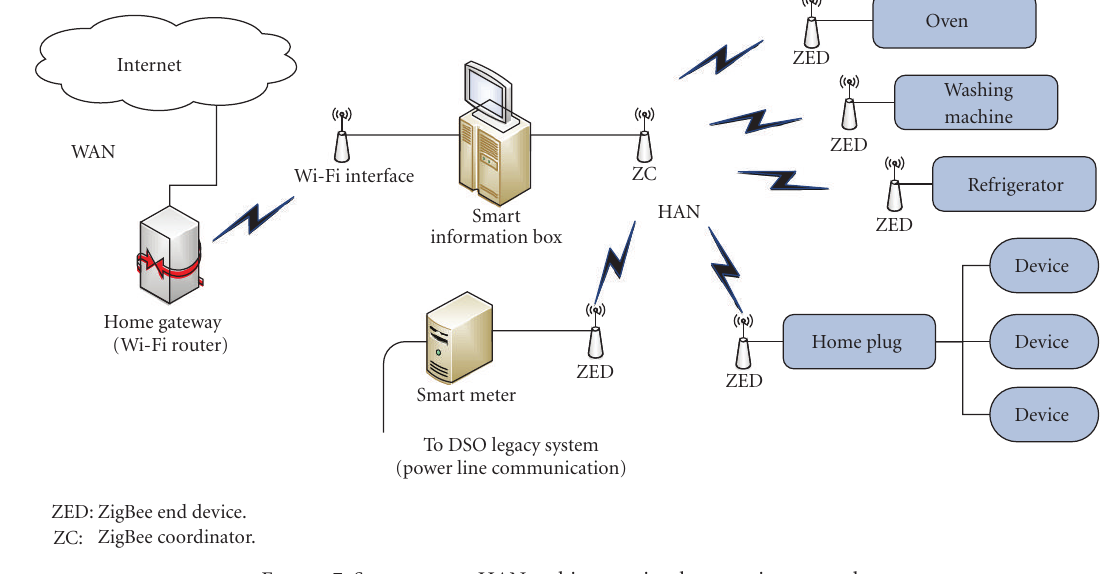
Figure 7: Smart energy HAN architecture implementation example.